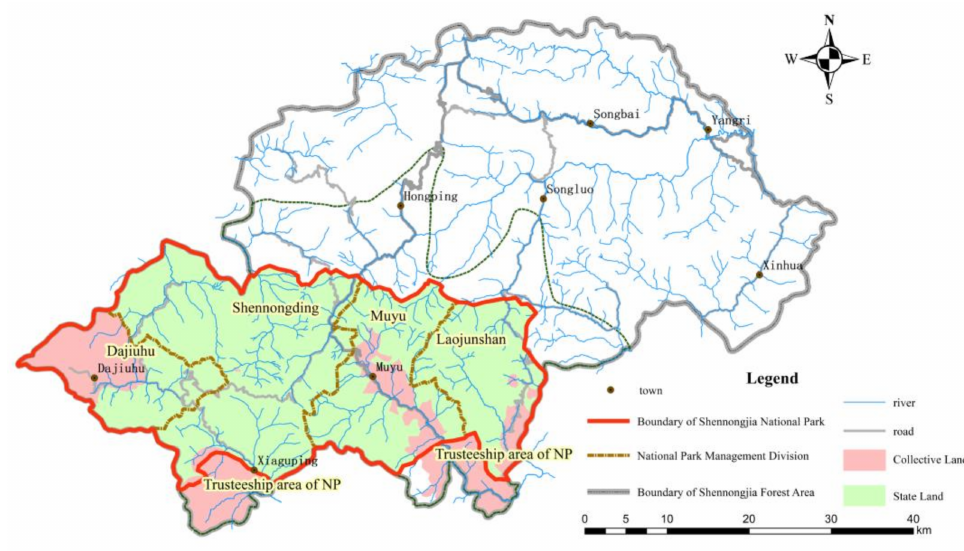
Figure 2. Shennongjia National Park study